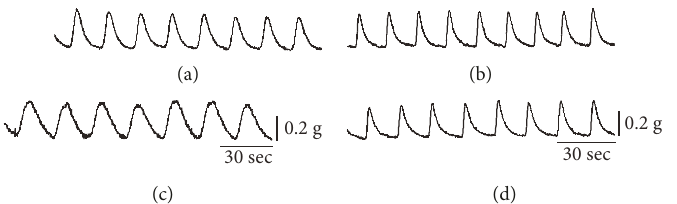
Figure 6: Spontaneous phasic contractile activities of nondiabetic and diabetic gastric fundus and antrum muscles. Representative traces of the spontaneous phasic contractions of muscle strips from (a) nondiabetic and (b) diabetic fundus muscles and (c) nondiabetic and (d) diabetic antrum muscles ( n = 5 nondiabetic fundus and antrum muscles; n = 5 diabetic fundus and antrum